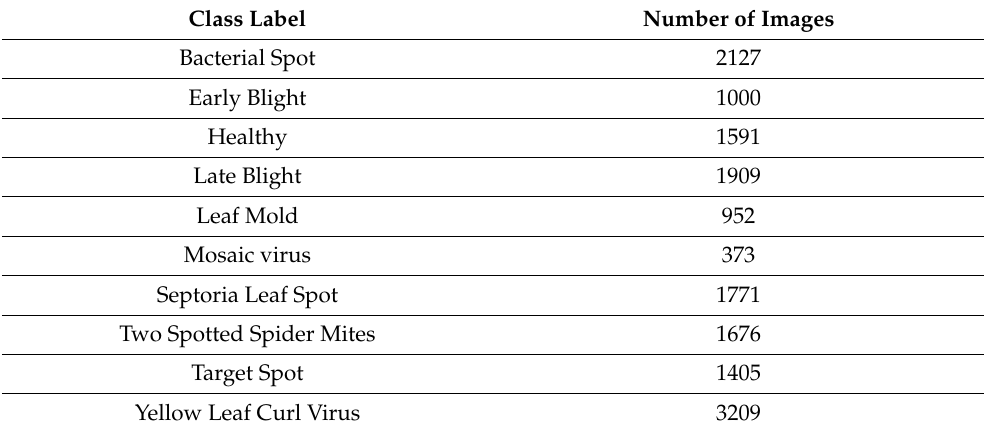
Table 1. The distribution of pictures among each class label of the PlantVillage